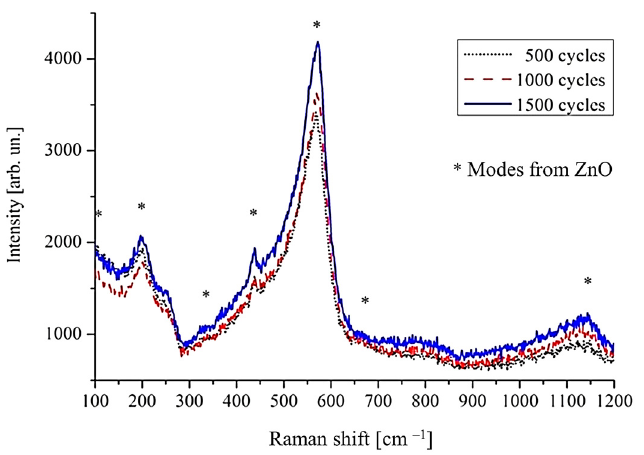
Figure 8. Raman spectra of the ZnO thin film deposited on scalpel surface after 500, 1000, and 1500 cycles.